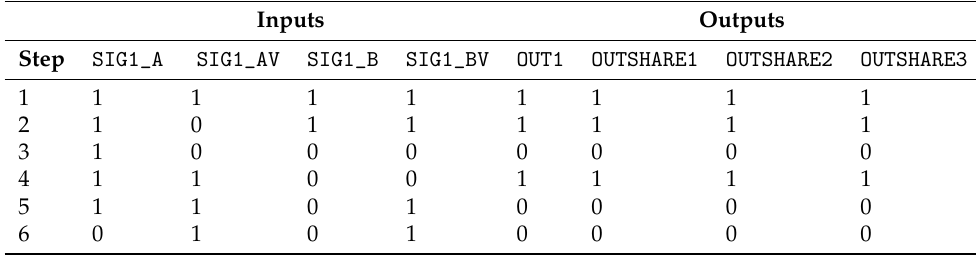
Table 3. Test Case 1—Smoke and Fire.